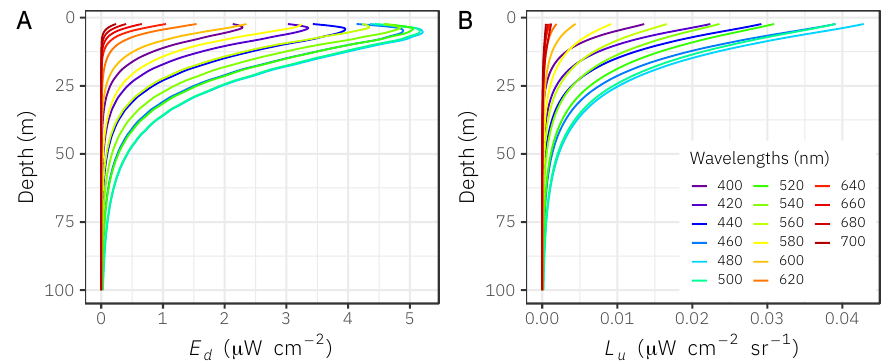
Figure 3. Examples of in situ downward irradiance ( E d ( z ) ) and upward radiance ( L u ( z ) ) profiles measured under-ice on 20 June 2016. Note the presence of subsurface maxima in the downward irradiance profiles and the absence of subsurface maxima in the upward radiance profiles.